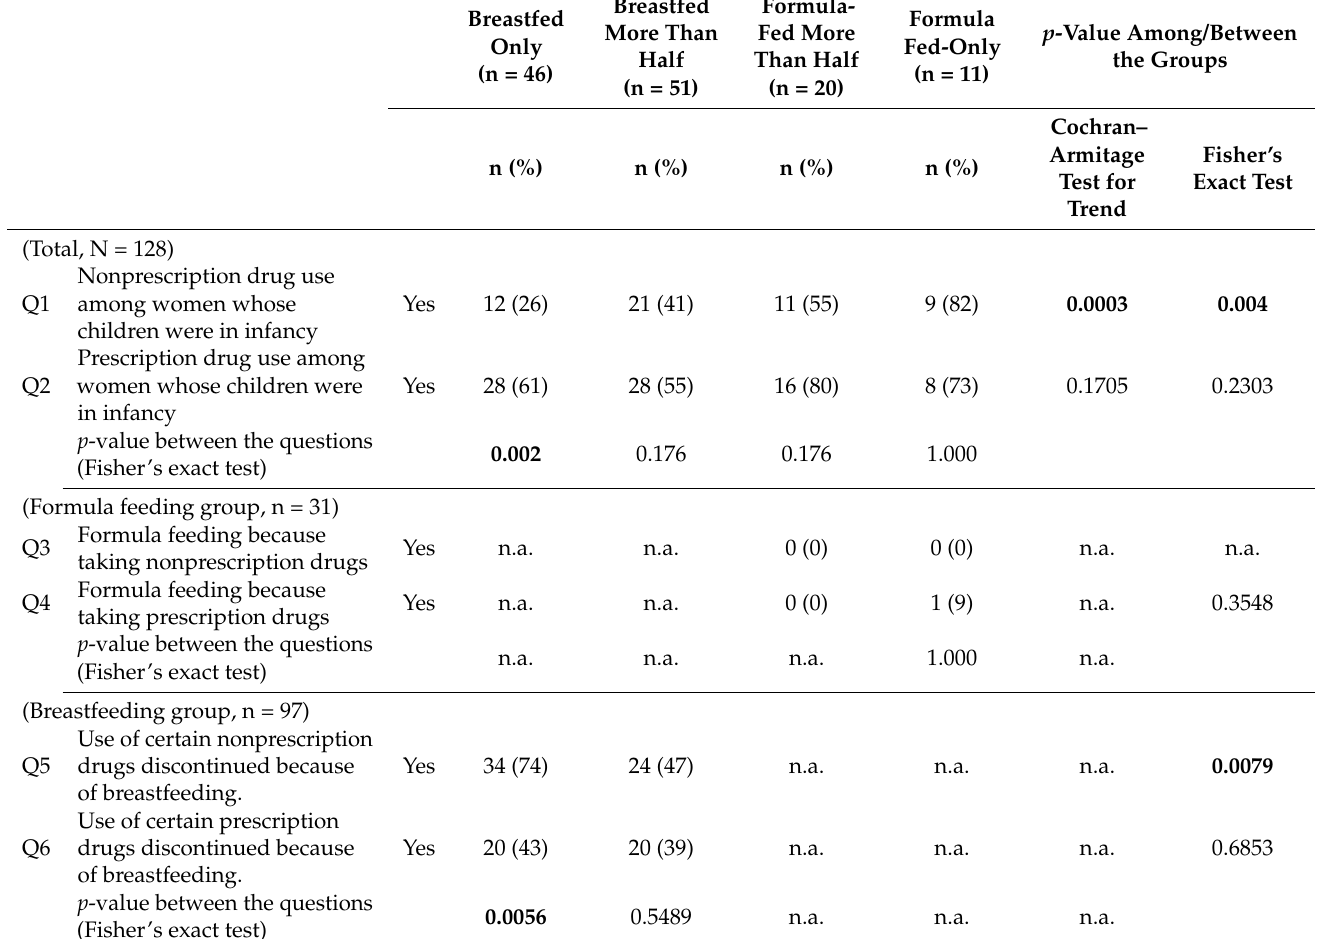
Table 1. Relationships between medication use and